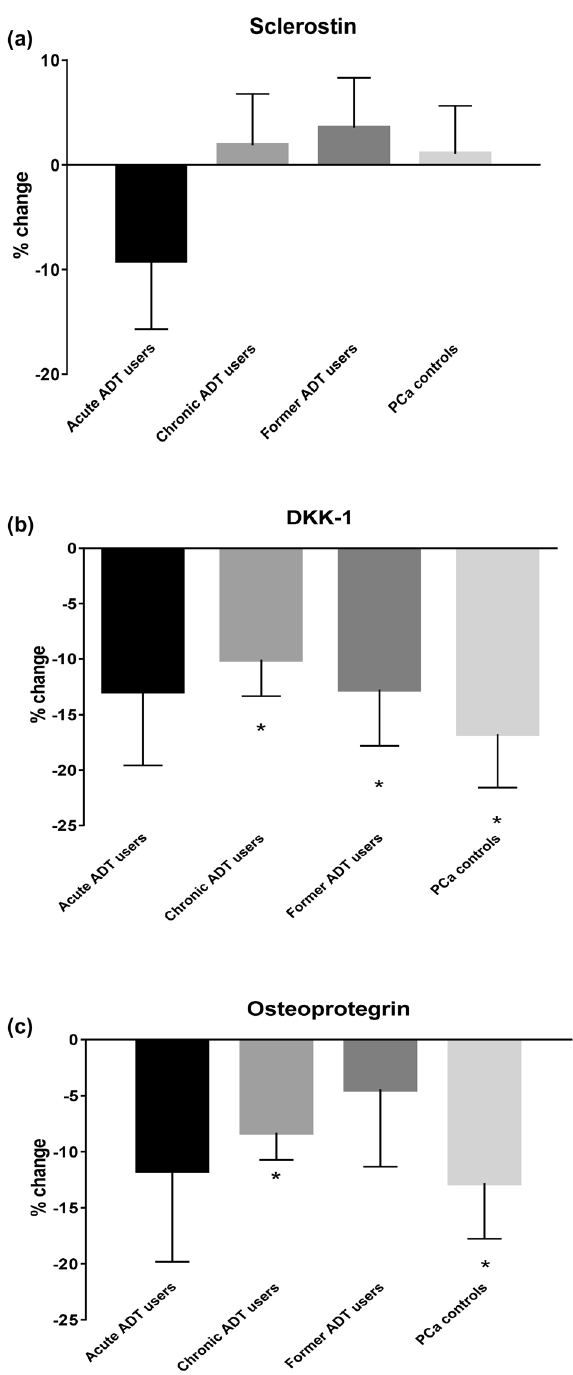
Figure 1. Least squares mean percentage changes from baseline to 6 months in serum ( a ) sclerostin, ( b ) DKK- 1, and ( c ) OPG. Acute ADT users n = 6, chronic ADT users n = 24, Former ADT users n = 16, and PCa controls n = 26. *Significantly changed from baseline, p <